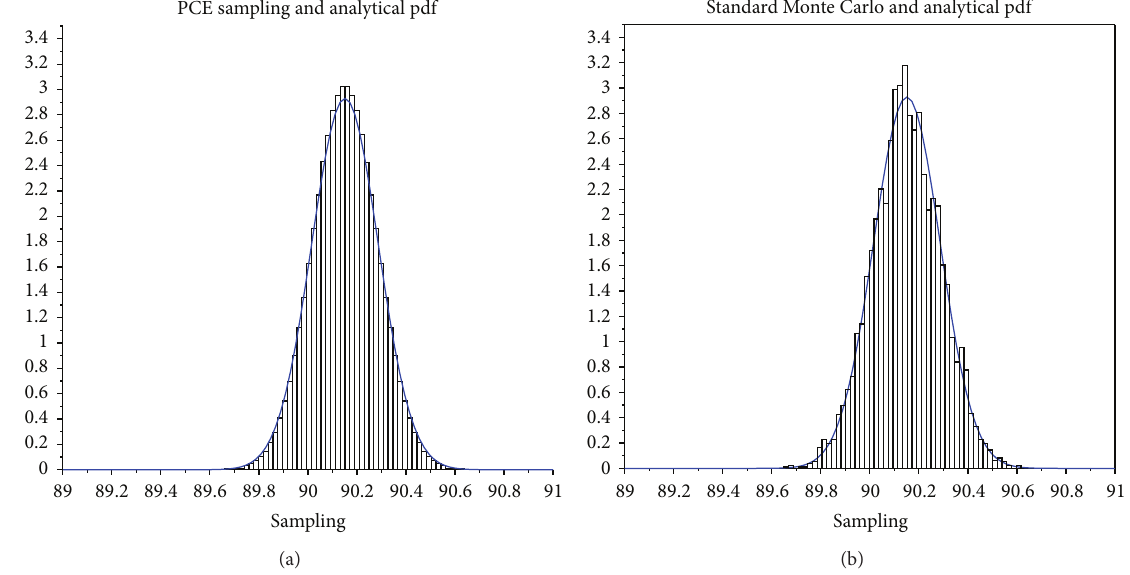
Figure 11: (a) Probability density function of Vasicek interest rate model, with parameters 𝛼 = 0.1 , 𝛽 = 0.2 , 𝜎 = 0.15 , and 𝑅 0 = 110 (blue curve)andhistogramofasampling(size= 5000 )ofthe 𝑅 (𝑝) 𝑇 for 𝑝 = 15 .Withthesameparameters,in(b),wecomparetheanalyticalprobability density function of the Vasicek model, with the one obtained using the Monte Carlo sampling of size 5000 , for 𝑅 𝑇 , being 𝑇 = 1 .